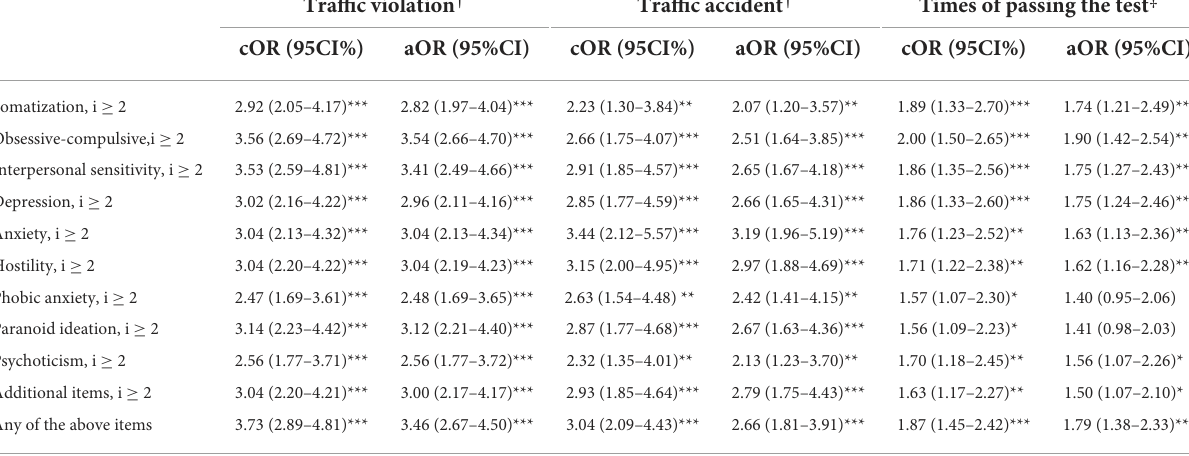
TABLE 8 Associations between each psychological symptom and traffic violation/traffic accident/frequencies of passing the driver’s license’s test examined by ordered logistic regression. Traffic violation